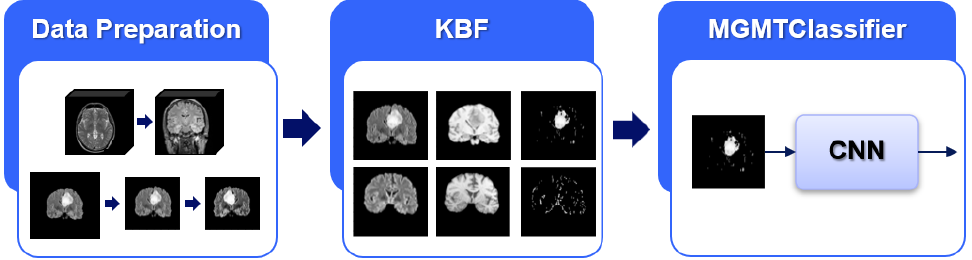
Figure 1. Exemplified schema of the proposed approach: on the left, the Data Preparation step gener- ates isotropic and normalized acquisitions; in the middle, the Knowledge-Based Filtering (KBF) step leverages the medical knowledge to pre-select, in an unsupervised manner, the ROI corresponding to suspect lesions; on the right, the MGMT promoter methylation identification step adopts a CNN for the identification of the methylation